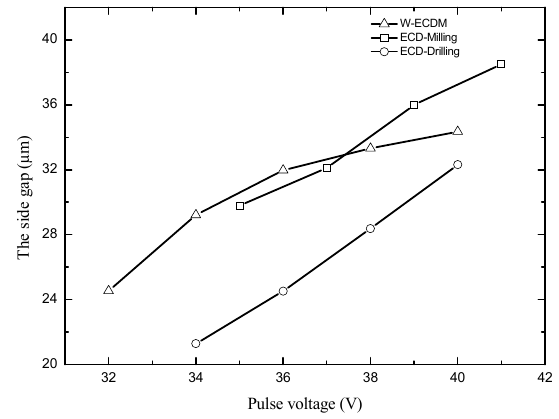
Figure 5. Effect of pulse voltage on side gap.